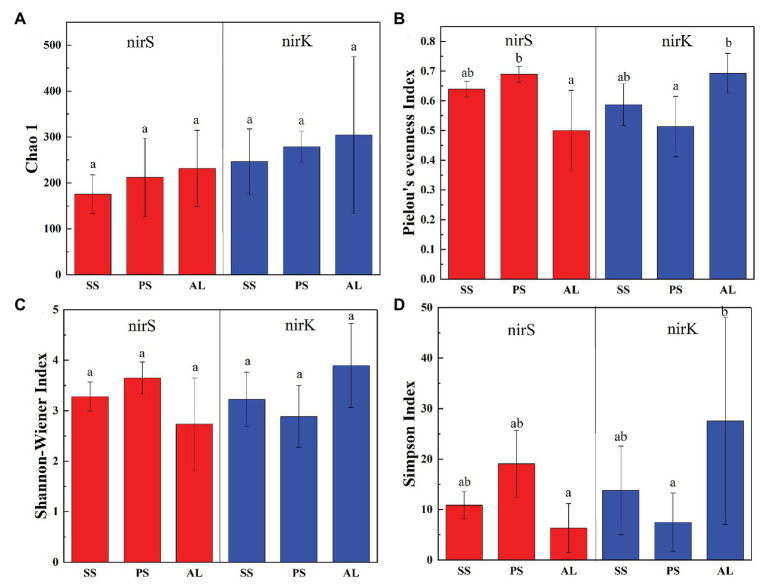
Richness and diversity of nirS and nirK genes in seal colony soils (SS), penguin colony soils (PS), and animal-lacking tundra soils (AL) in maritime Antarctica. (A) Chao 1, (B) Pielou’s evenness Index, (C) Shannon-Wiener Index, (D) Simpson Index. The error bars indicate standard deviations of the averages. The different letters indicated statistically significant differences (ANOVA, p < 0.05).